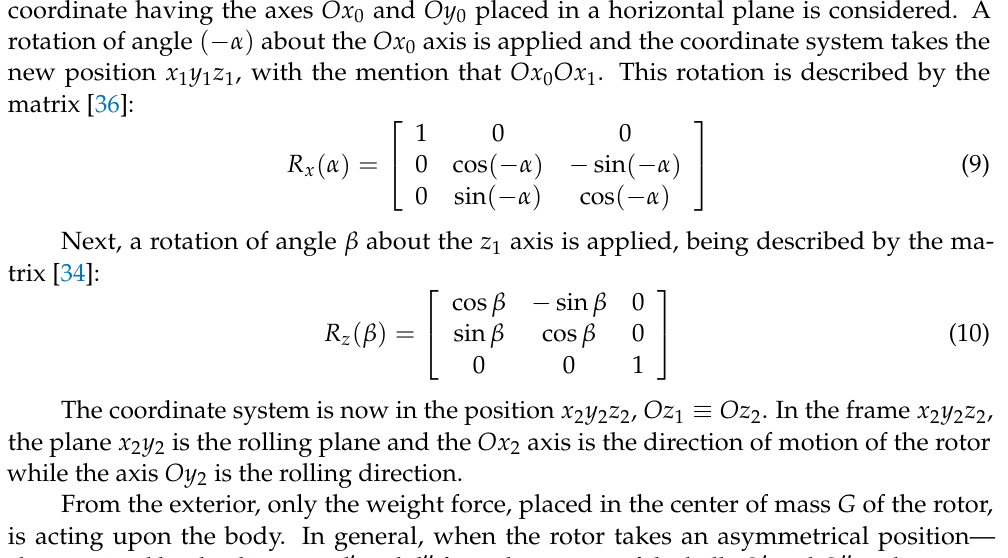
Figure 5. Finding the position of the center of mass G from the free body diagram of the rotor. To obtain the inclined plane with the attached frame x 2 y 2 z 2 , the x 0 y 0 z 0 system of coordinate having the axes Ox 0 and Oy 0 placed in a horizontal plane is considered. A rotation of angle ( − α ) about the Ox 0 axis is applied and the coordinate system takes the new position x 1 y 1 z 1 , with the mention that Ox 0 Ox 1 . This rotation is described by